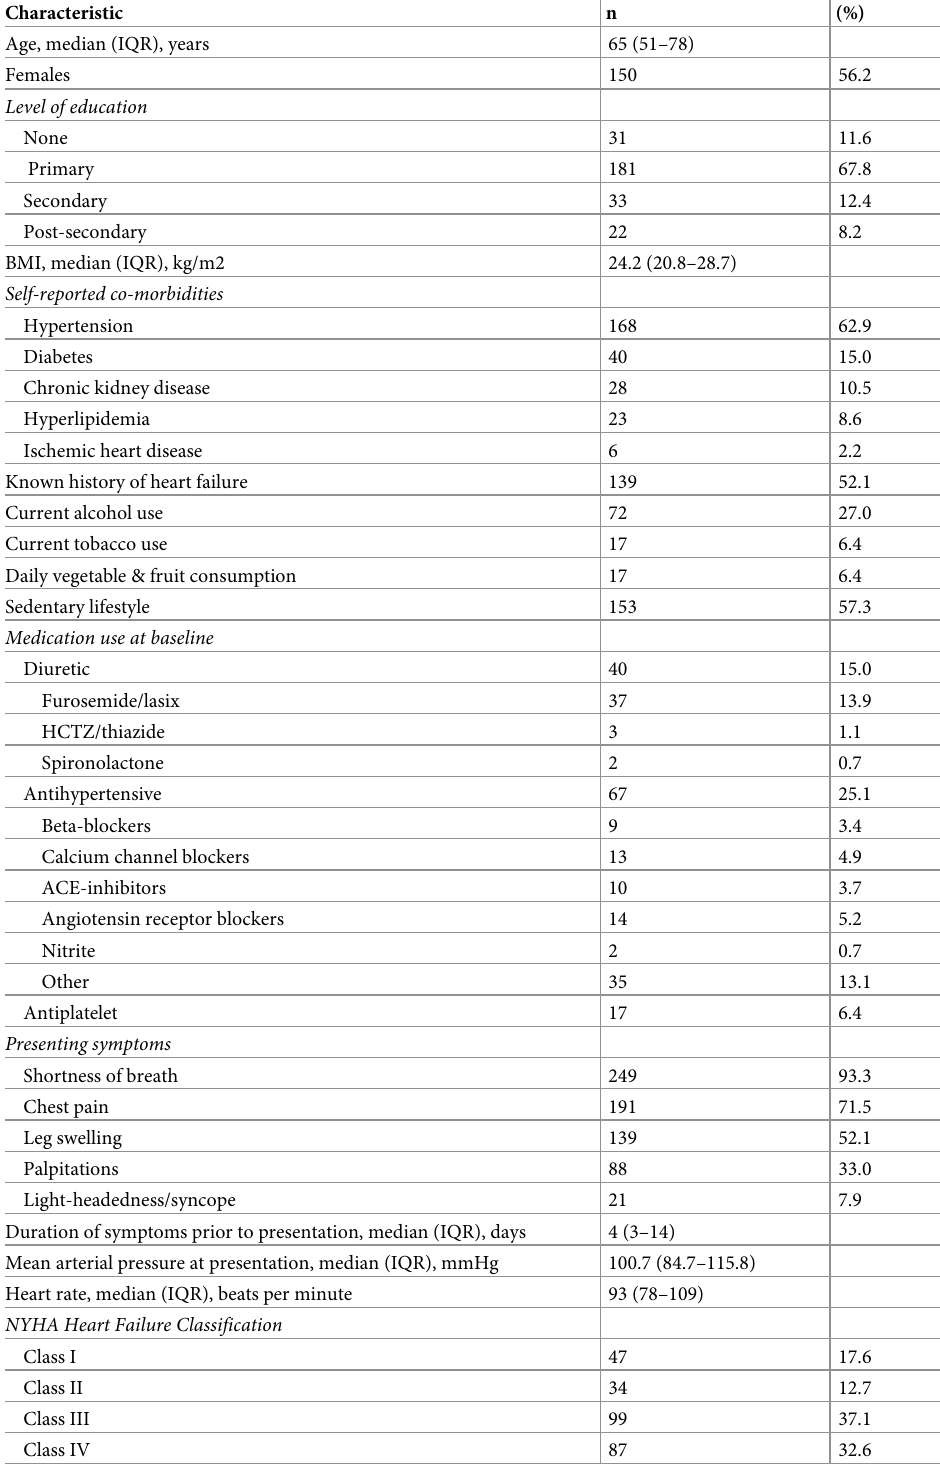
Table 1. Characteristics of adults presenting to the KCMC emergency department and diagnosed with heart fail- ure, 2018–2019 (n =